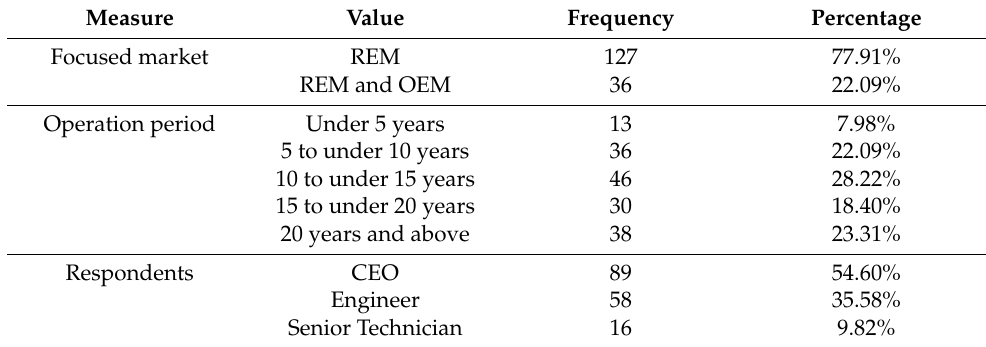
Table 1. Characteristics of the samples.